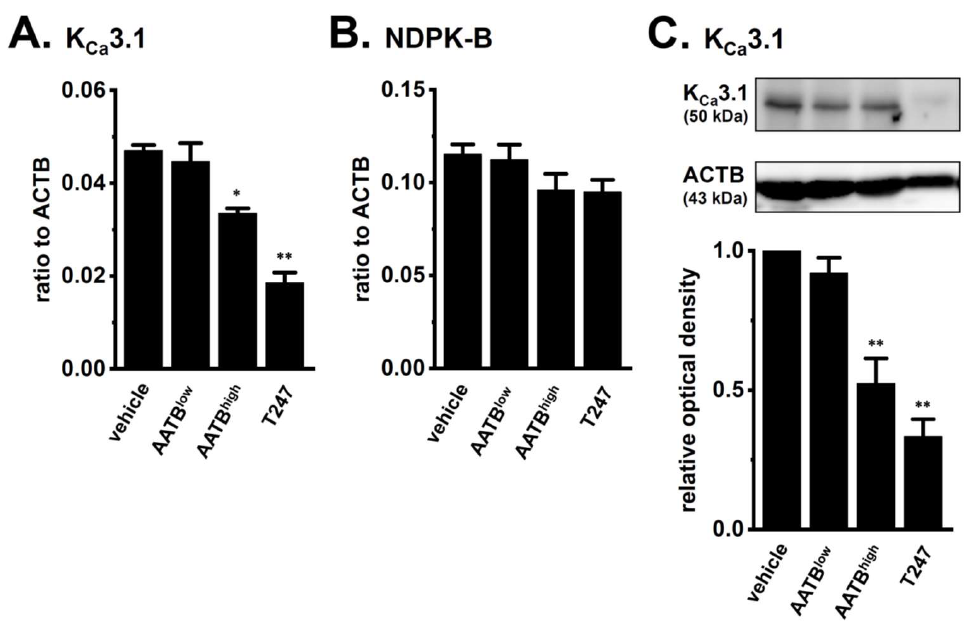
Figure 5. Effects of the treatment with the selective HDACis, AATB and T247 on the expression of K Ca 3.1 and NDPK-B in splenic CD4 + T cells of IBD model mice. ( A , B ) Real-time PCR assay for K Ca 3.1 ( A ) and NDPK-B ( B ) in “vehicle”-, 30 nM AATB (“AATB low ”)-, 300 nM AATB (“AATB high ”)-, and 1 µ M “T247”-treated CD4 + T cells ( n = 4 for each). Expression levels were expressed as a ratio to ACTB. ( C ) Protein lysates of in vehicle-, AATB low -, AATB high -, and T247-treated CD4 + T cells were probed by immunoblotting with anti-K Ca 3.1 (upper panel) and anti-ACTB (lower panel) antibodies on the same filter. Summarized results were obtained as the optical density of K Ca 3.1 and ACTB band signals. After compensation for the optical density of the K Ca 3.1 protein band signal with that of the ACTB signal, the K Ca 3.1 signal in the vehicle control was expressed as 1.0 ( n = 4 for each). Results are expressed as means ± SEM. *, **: p < 0.05, 0.01 vs. vehicle control.